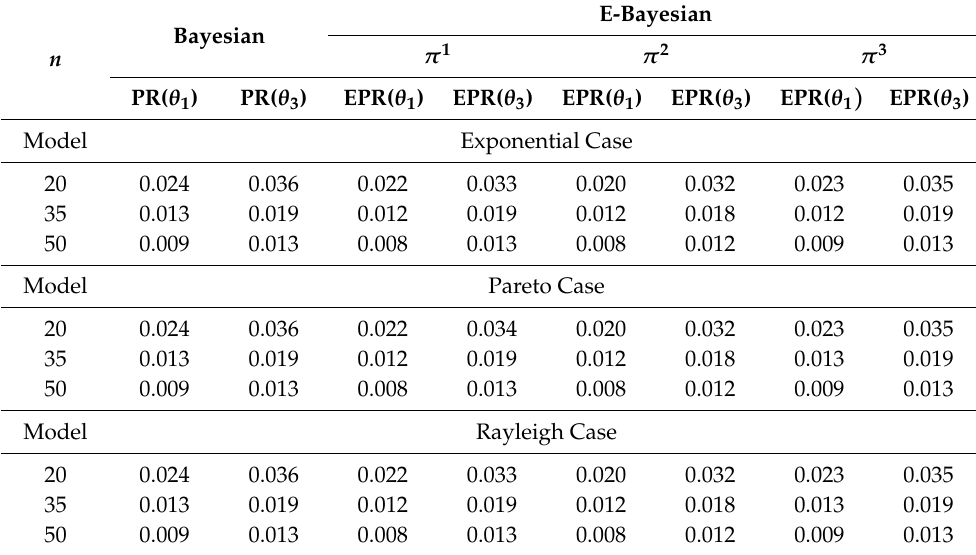
Table 10. The PR and EPR of Bayes estimators for parameters ( θ 1 , θ 3 ) with ( c 1 , c 2 , c 3 ) = ( 3,2.5,2 ) .